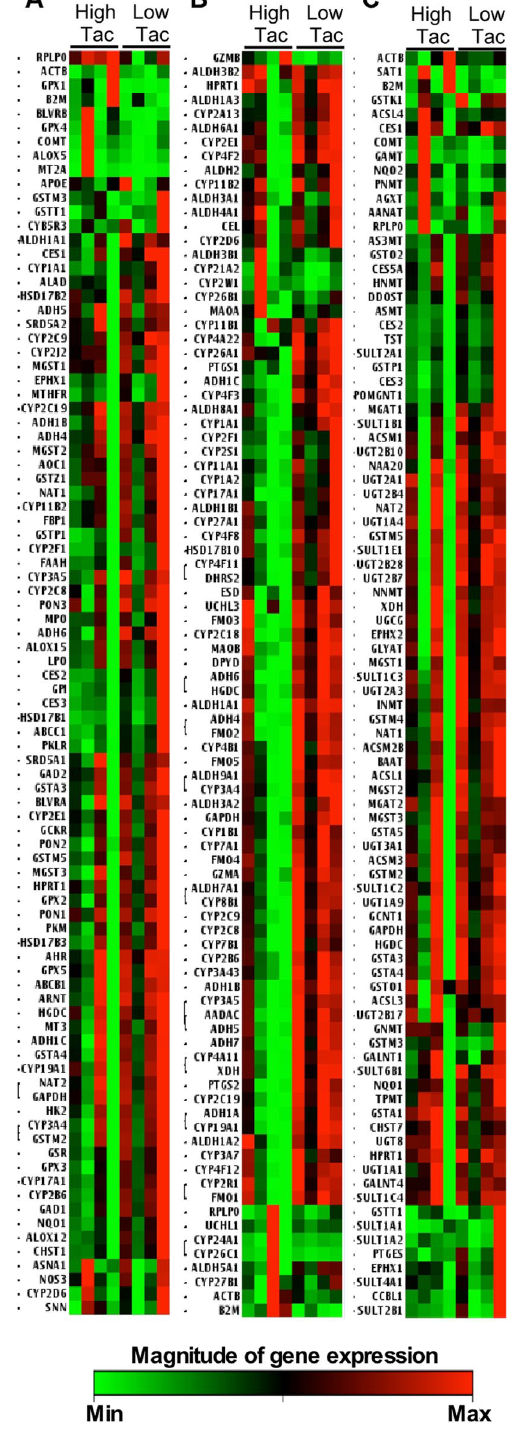
Figure 2. Heat map of three human drug metabolism PCR arrays. ( A ) Drug metabolism PCR array, ( B ) Phase I enzymes PCR array, ( C ) Phase II enzymes PCR array. Gene expression levels in low and the high tacrolimus (Tac) groups in liver transplant receipts are